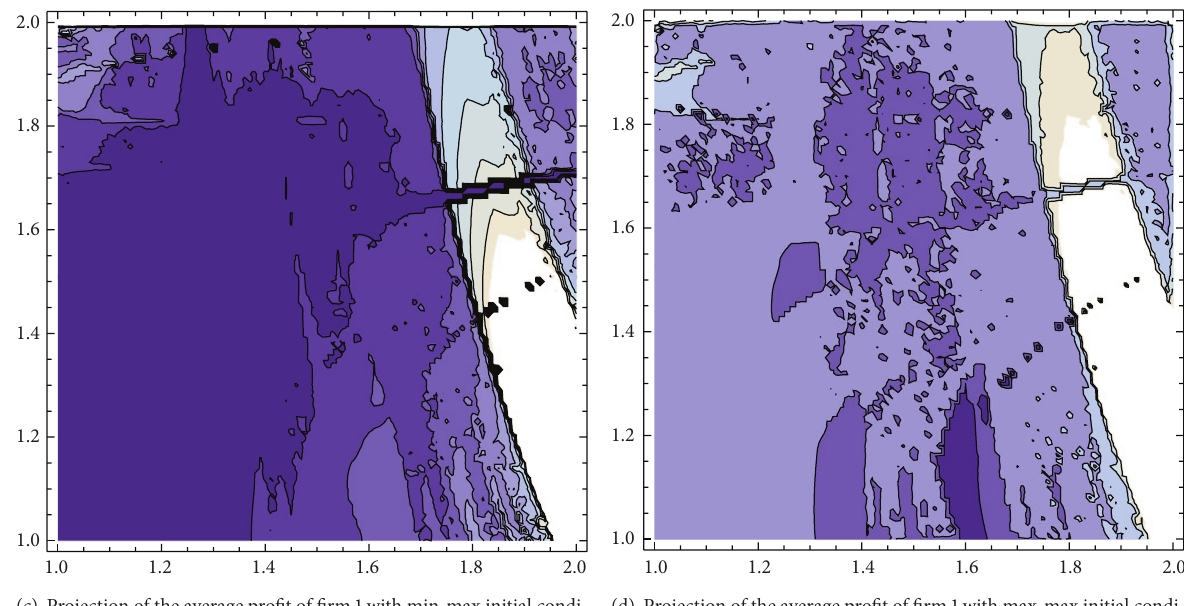
Figure 16: Average profit for firm 1 with different initial conditions. Note that in projections, the darker the color is, the lower the average profit